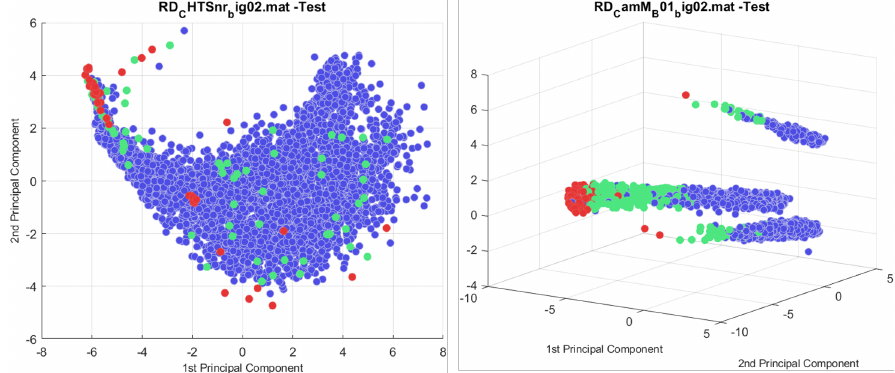
Figure 4. A PCA plot of datasets 1 and